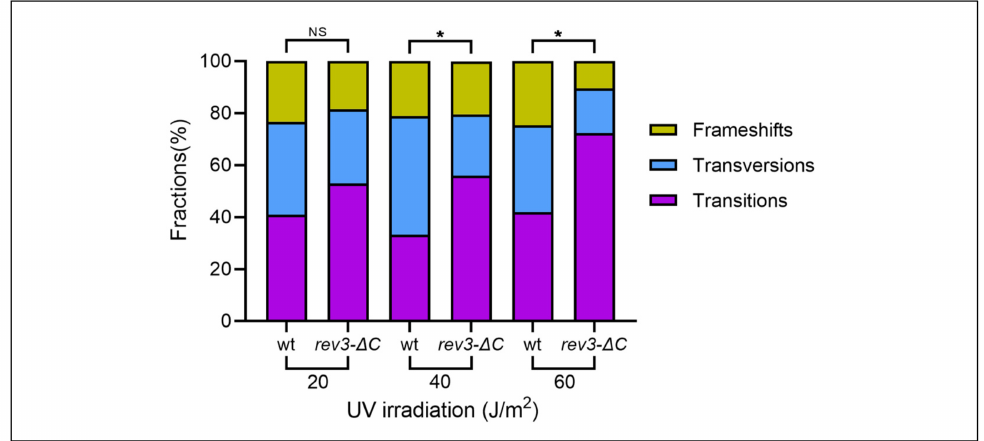
Figure 4. The proportion of transversion mutations progressively decreased with increasing UV- dose in the mutation spectra of rev3- ∆ C . Breakdown of proportions of different classes of mutations detected at 20 J/m 2 , 40 J/m 2 , and 60 J/m 2 . * p <